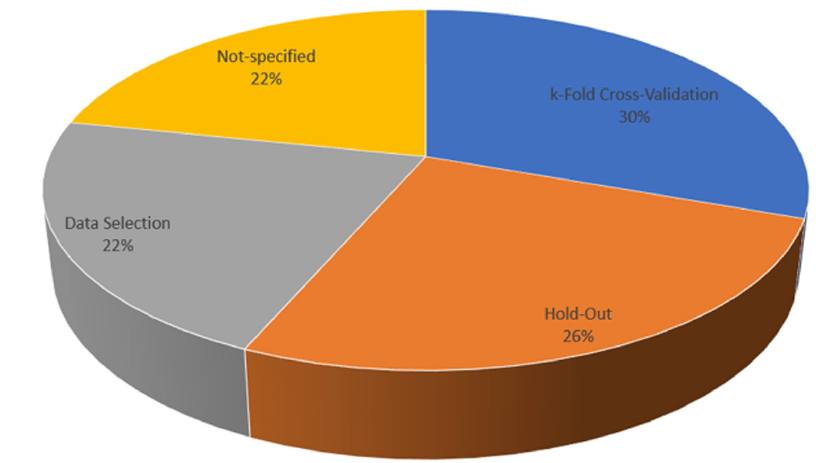
Figure 7. Validation strategies in the student performance prediction